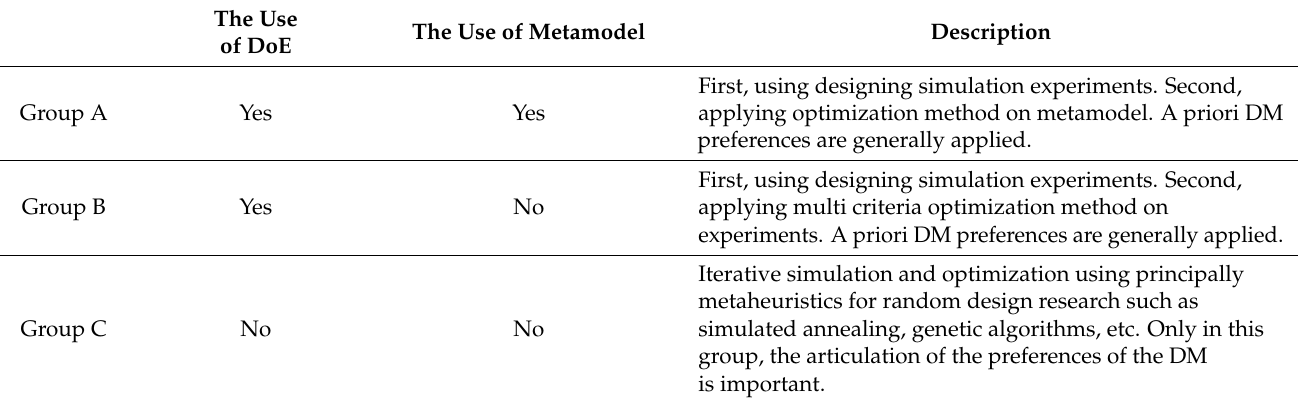
Table 1. The proposed MOSO classification for FMS design.